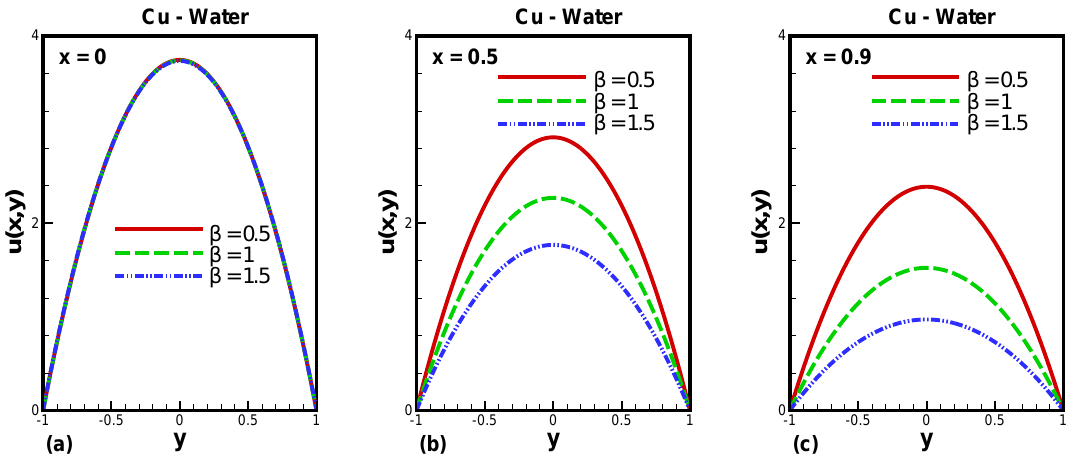
Figure 8. Effect of β on dimensionless longitudinal velocity at the ( a ) entrance, ( b ) middle, and ( c ) exit regions of the channel, when φ = 0.05, δ = 0.2, and γ =